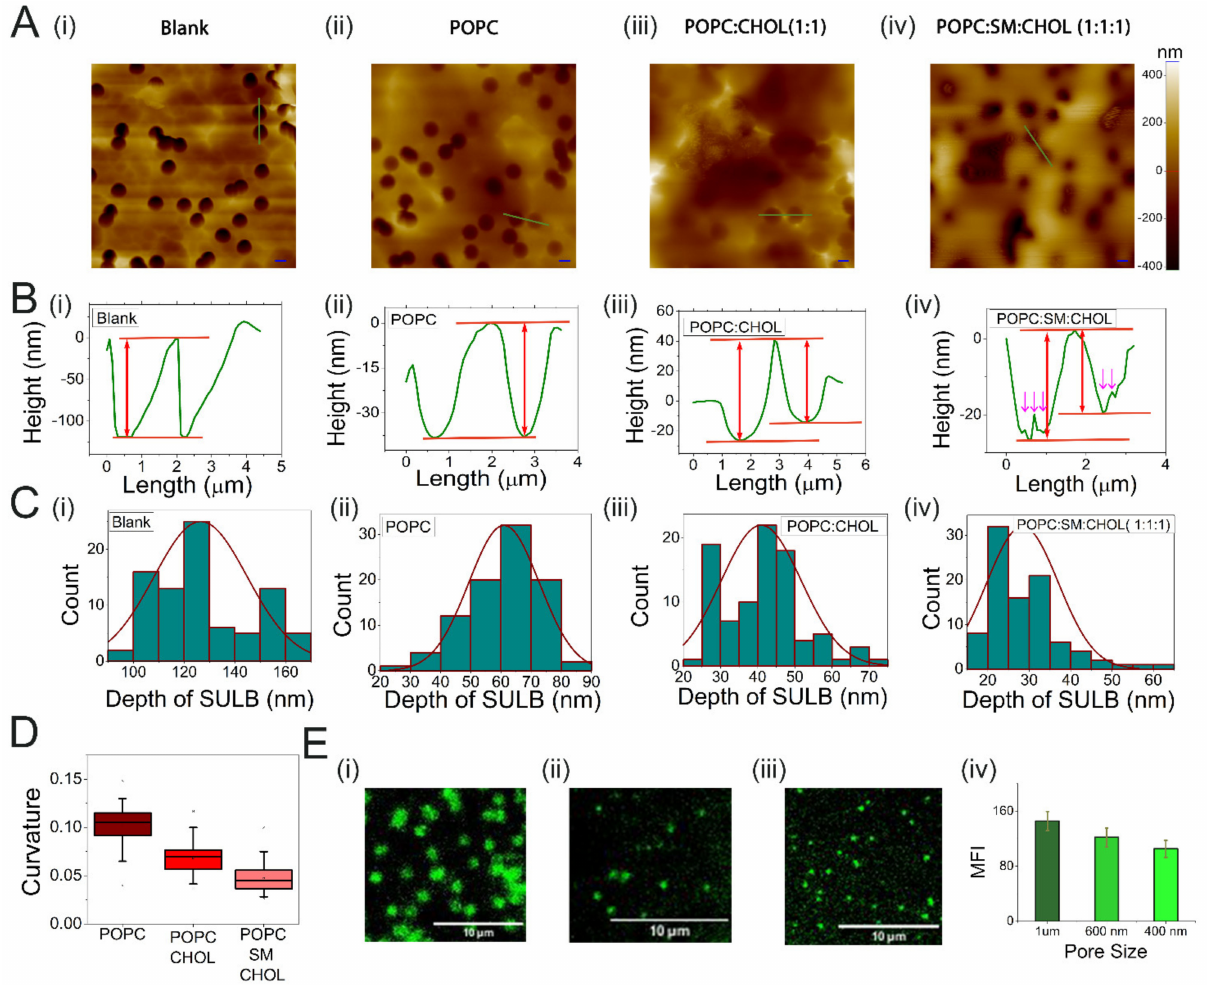
Figure 2. Characterization of SULB system. ( A ) AFM topographic images, ( B ) line profiles and ( C ) the distribution of the depth of the microwells for ( i ) Blank PCTE substrate, ( ii ) POPC SULB, ( iii ) POPC:CHOL (1:1) SULB, and ( iv ) POPC:SM:CHOL (1:1:1) SULB are shown. Scale bar = 2 µ m in panel. The average size of the microwells was found to be 1.2 µ m. ( A ) The arrows in ( B ( iv )) indicate the surface roughness in ternary Suspended bilayer which may appear due to the Lo/Ld phase separation. ( D ) Curvature distribution of SULB systems prepared with different lipid compositions. The error bar represents the standard deviation. The total number of cavities, n = 85 for blank, n = 91 for POPC, n = 91 for binary and n = 92 for ternary system are measured. ( E ) Fluorescence microscopy images of DiI labeled SULB system of microwell size ( i ) 1 µ m, ( ii ) 600 nm, and ( iii ) 400 nm. ( iv ) Mean fluorescence intensity of DiI labeled suspended bilayer for different microwell size. Scale bar = 10 µ